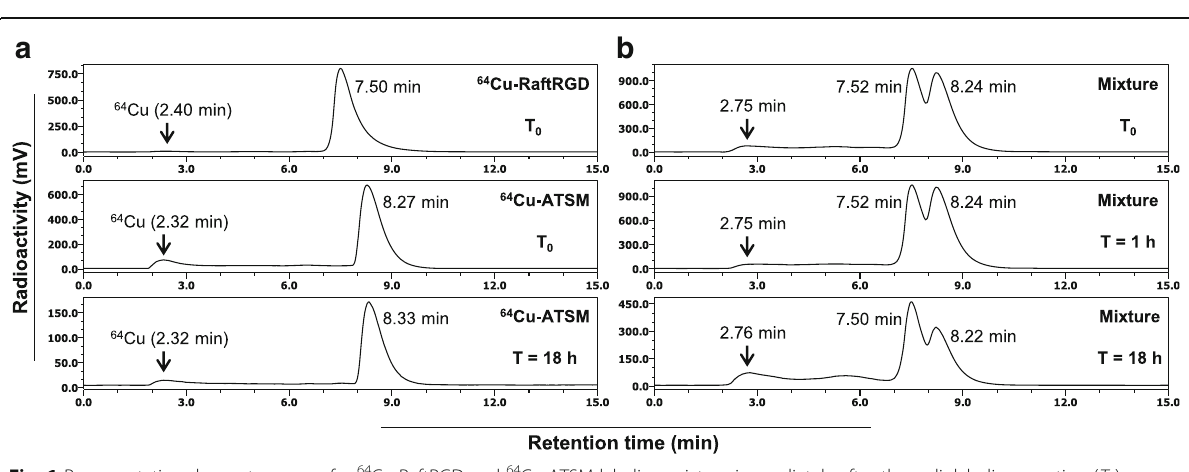
Fig. 1 Representative chromatograms of a 64 Cu-RaftRGD and 64 Cu-ATSM labeling mixture immediately after the radiolabeling reaction ( T 0 ) or after 18 h of storage at room temperature ( T = 18 h), and b the mixture of 64 Cu-RaftRGD and 64 Cu-ATSM immediately after mixing ( T 0 ) or after 1 and 18 h of storage at room temperature ( T = 1, 18